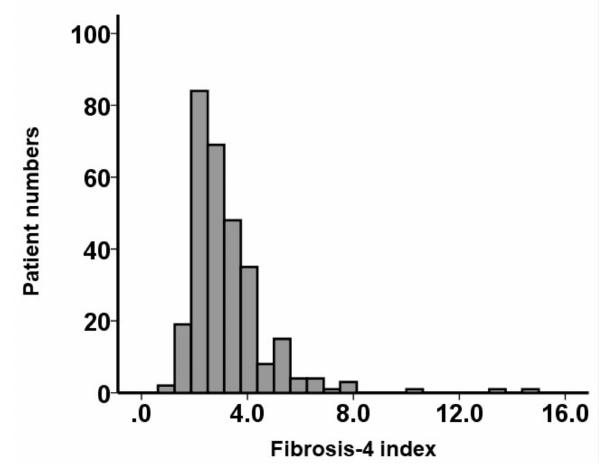
Figure 1. Distribution of the baseline fibrosis-4 index.